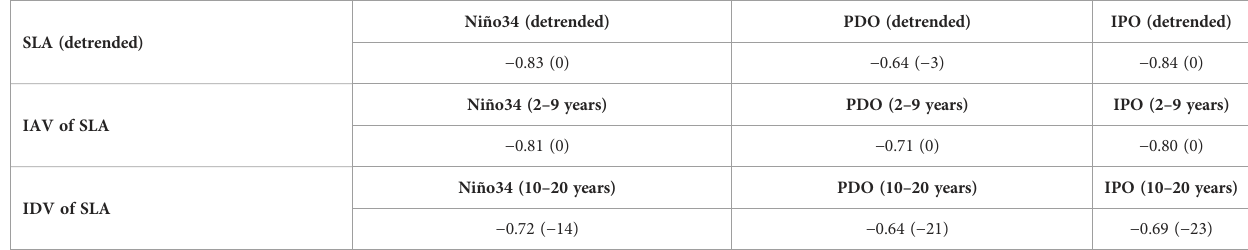
The correlations are statistically signi fi cant at 95% con fi dence level are shown.